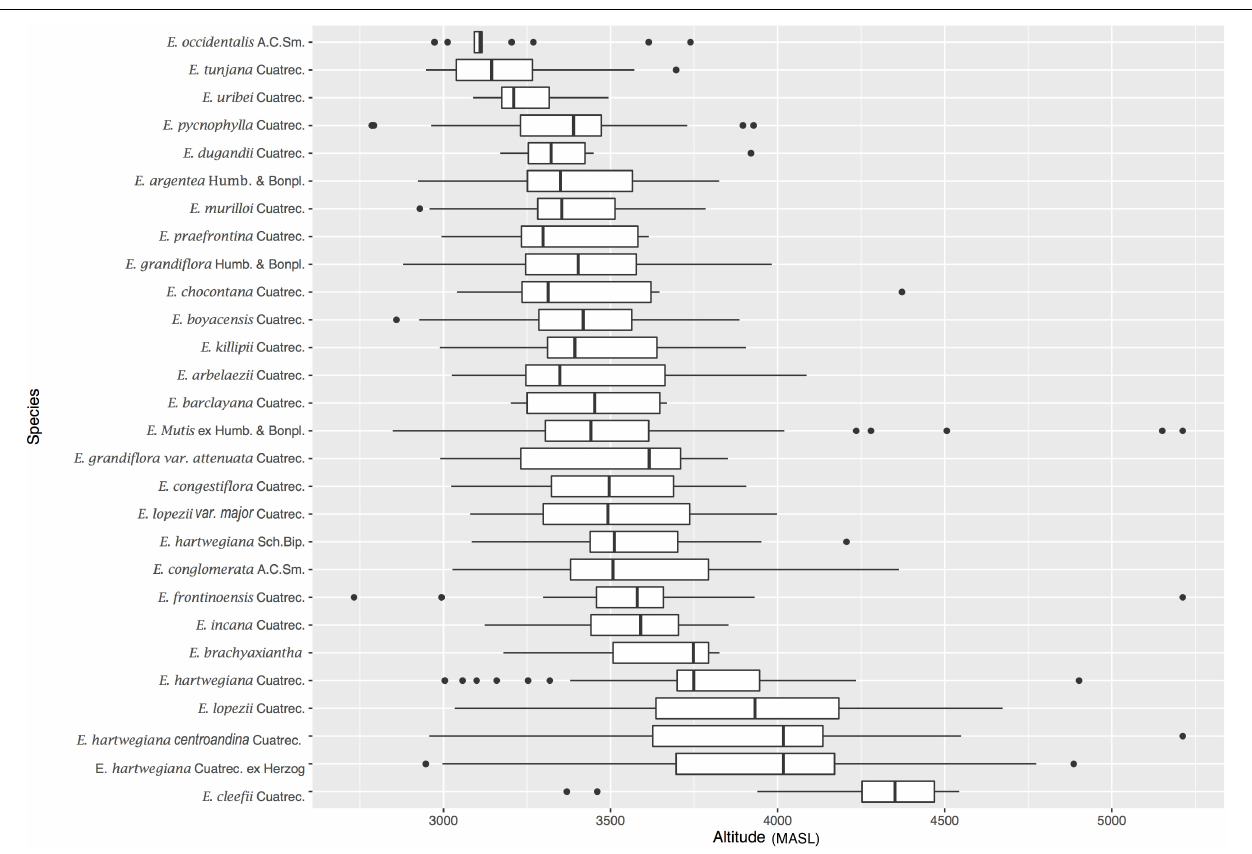
FIGURE 1 | Altitudinal profile (m asl) of 28 Espeletia taxa across Páramo sky islands in the Colombian Andes. A total of 1,432 occurrences, originally gathered as georeferenced specimen data from GBIF, were retained after cleaning for georeferencing consistency (i.e., non-redundant records located within the study area) and number of records per species (to avoid distributions with less than 10 points, following Van Proosdij et al. (2016) for narrow-ranged species). Espeletia taxonomy is in accordance with Cuatrecasas